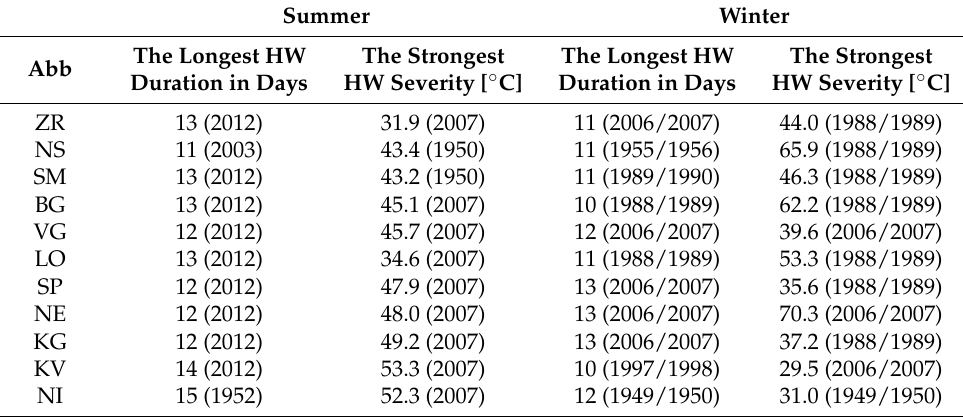
Table 7. The longest HW duration in days (year) and strongest HW severity in ◦ C (year) for 11 stations in Serbia during the summer and winter from 1949 to